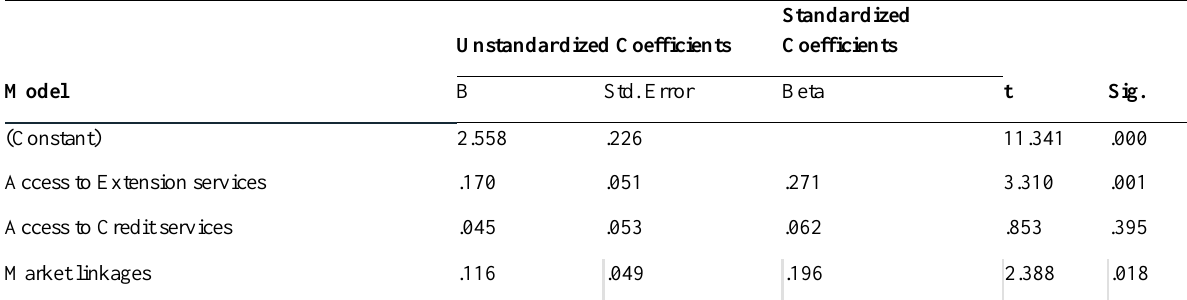
Table 9: Access to extension credit services, market linkages and sustainability of DFLPs